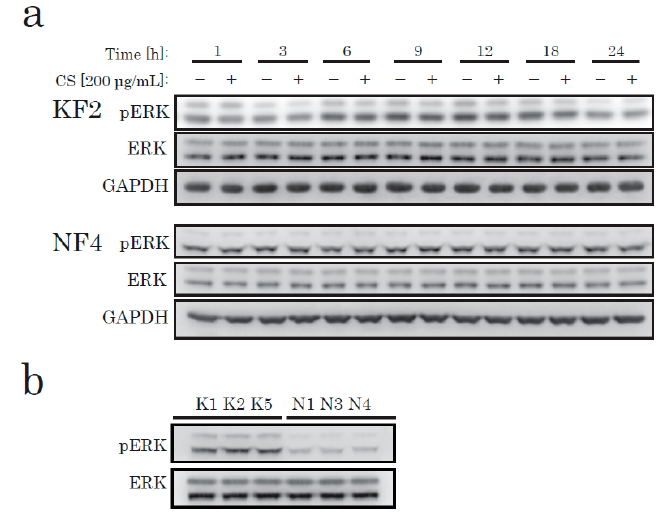
Figure 2. Western blotting of phospho-ERK (pERK) and total ERK (ERK) in KFs and NFs. KFs and NFs were treated with CS for up to 24 h. Soluble protein extract (8 µg/lane) was analyzed using